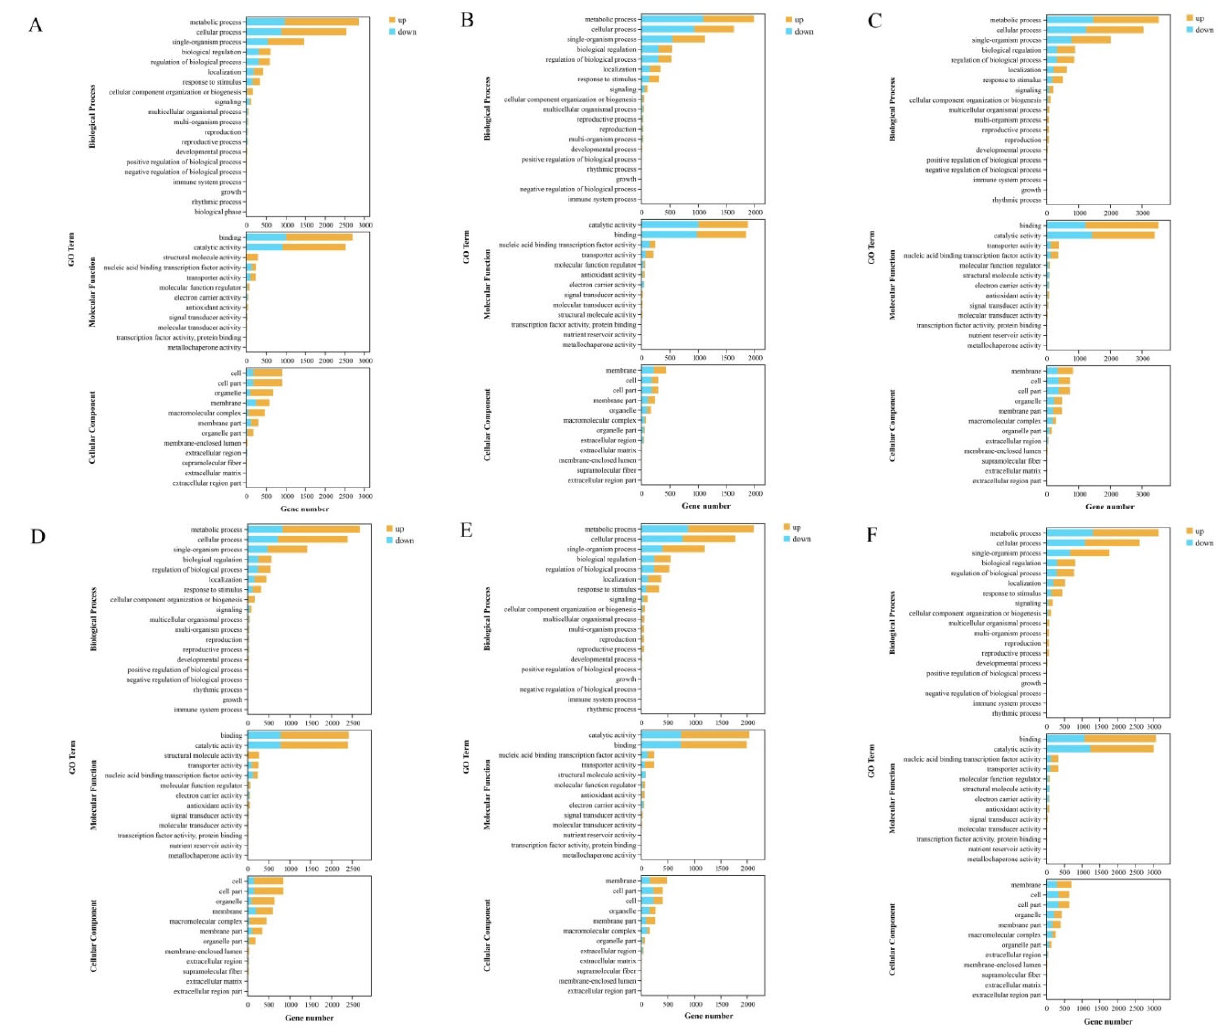
Figure 3. Gene Ontology (GO) function enrichment analysis of DEGs identified. ( A ) GO analysis of DEGs between 6 hpi vs. 0 hpi in susceptible variety. ( B ) GO analysis of DEGs between 48 hpi vs. 0 hpi in susceptible variety. ( C ) GO analysis of DEGs between 5 dpi vs. 0 hpi in susceptible variety. ( D ) GO analysis of DEGs between 6 hpi vs. 0 hpi in resistant variety. ( E ) GO analysis of DEGs between 48 hpi vs. 0 hpi in resistant variety. ( F ) GO analysis of DEGs between 5 dpi vs. 0 hpi in resistant